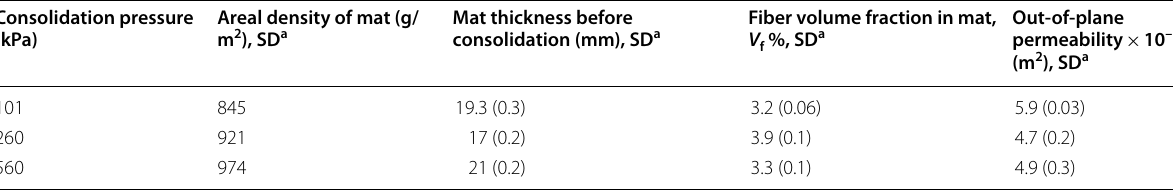
a SD—standard deviation, N